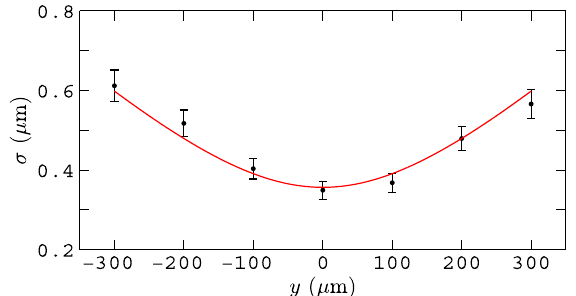
FIG. 23. Position resolution vs beam position; the red line shows a fit of the function σ ¼ p 1 ð y 2 þ p 2 Þ 1 = 2 , where p 1 and p 2 are